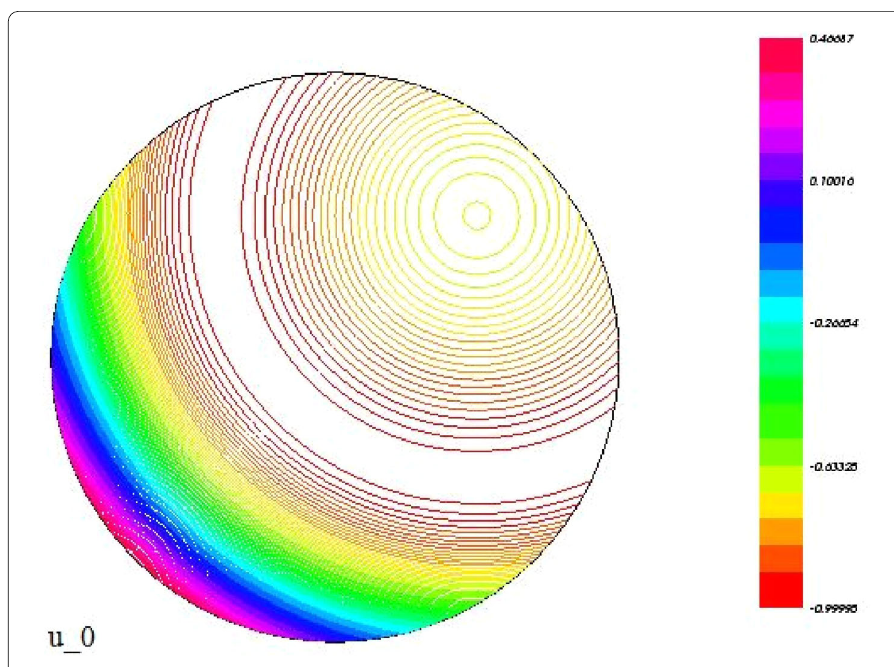
Figure 2 Isovalues of φ